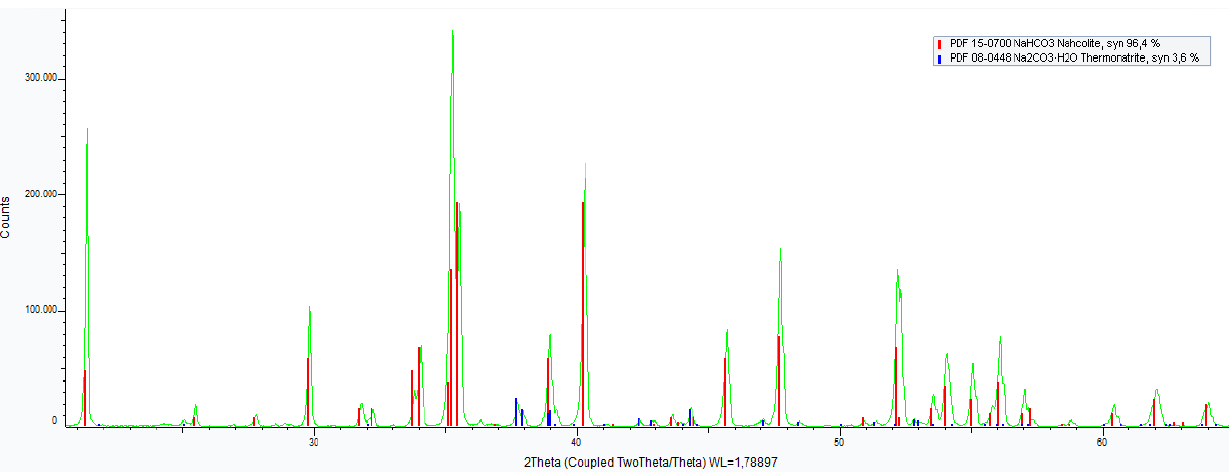
Figure B3. XRD quantitative analysis for crystals produced at 30 °C. Figure A4. XRD quantitative analysis for crystals produced at 30 ◦